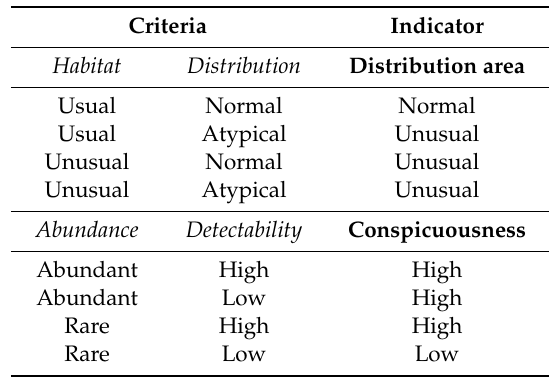
Table 2. Possible combinations of criteria resulting from di ff erent indicators used to assign species into categories of new records of birds in the Ecuadorian part of the Tumbesian region in the last two decades.